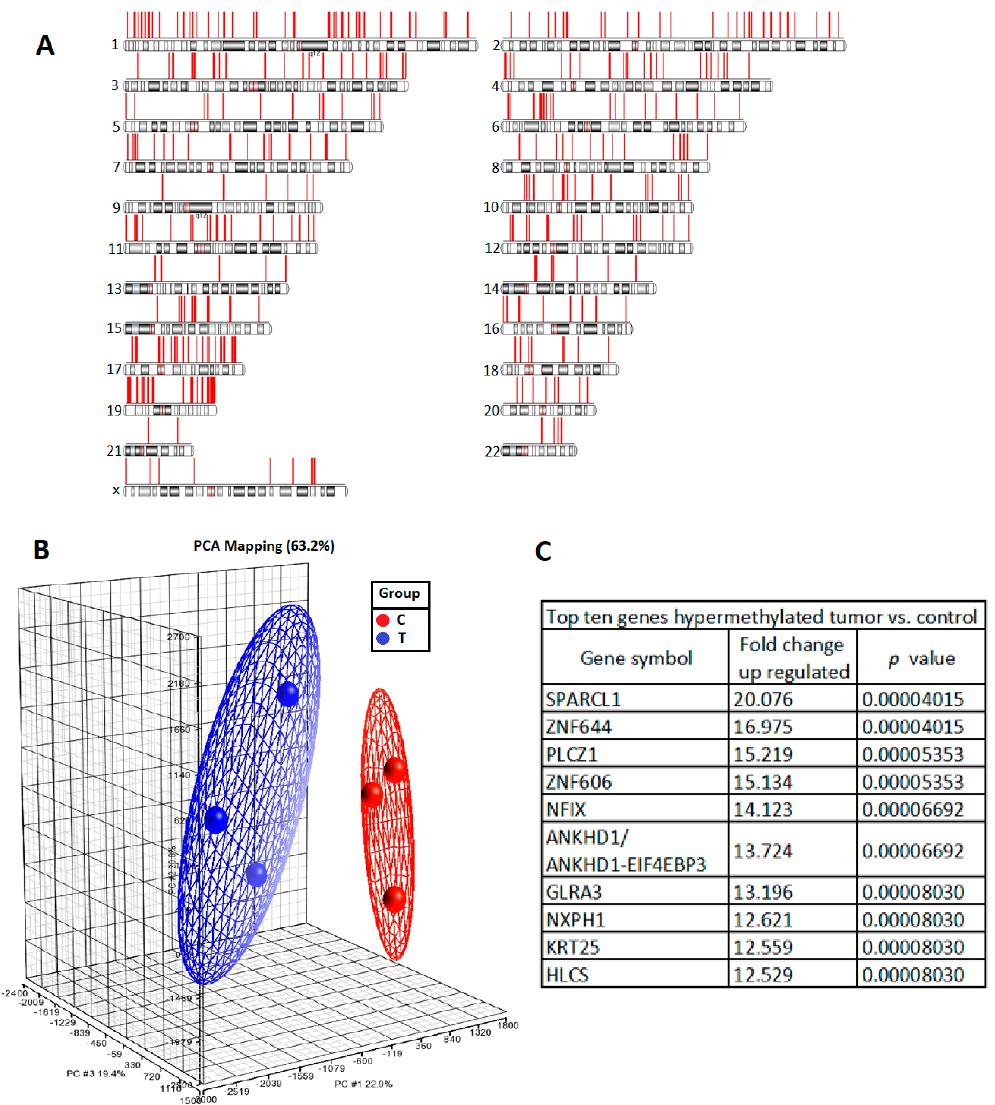
Figure 1. DNA methylation profiles between the high-grade and high-stage urothelial tumor and normal urothelium sets. We conducted methylation microarray assays on 3 UTUC and 3 normal urothelium samples and the raw data generated was analyzed with Partek. ( A ) Hypermethylated promoter region of each chromosome. ( B ) Principal component analysis plot based on methylation profiles in UTUC (red) and normal urothelium (blue). ( C ) The top-10 hypermethylated genes in UTUC compared with normal urothelium samples.